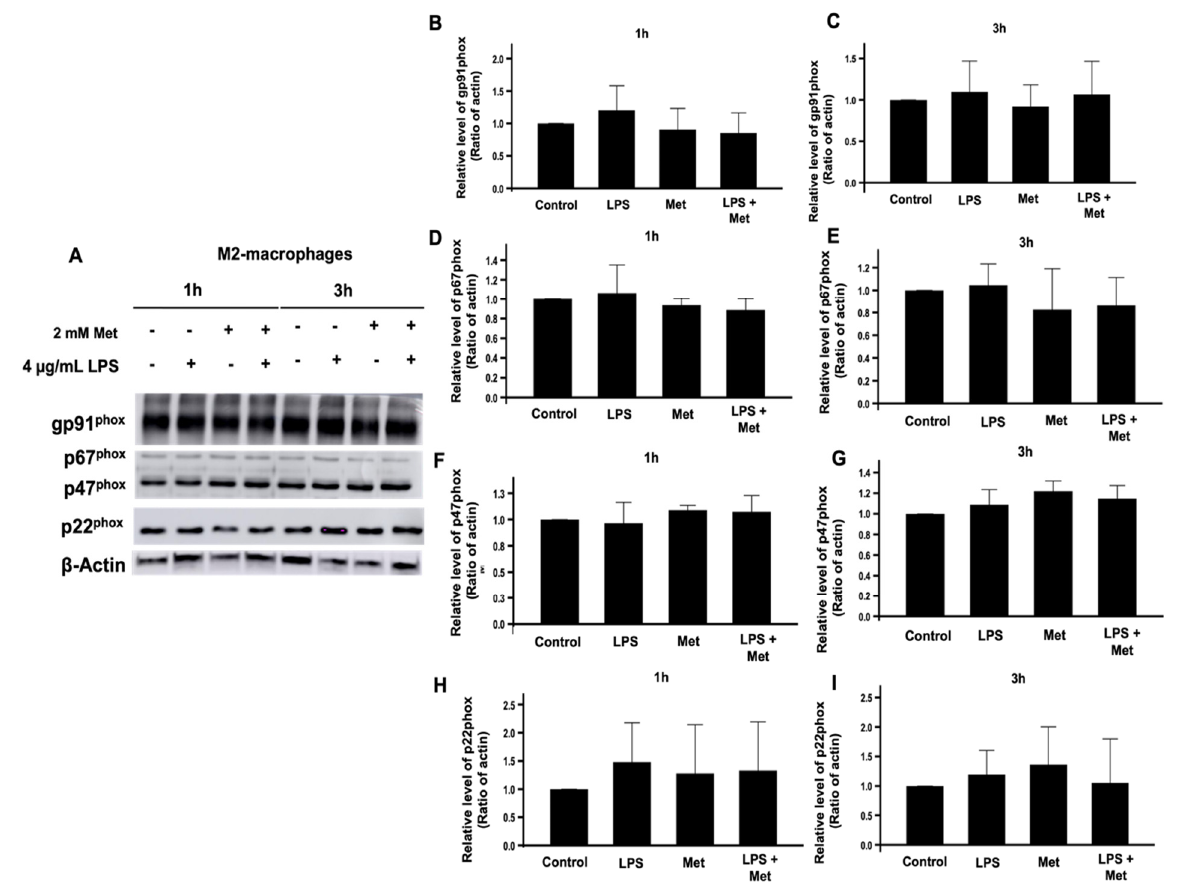
Figure 4. Effect of metformin on the expression of the NADPH oxidase components. M2 macrophages were incubated in the absence or the presence of 2 mM metformin then stimulated by LPS (4 µg/mL) for 1 and 3 h. The expression of gp91 phox , p22 phox , p47 phox , and p67 phox was evaluated compared to actin by SDS-PAGE and Western blot using specific antibodies ( A ). The gp91 phox ( B , C ), p67 phox ( D , E ), p47 phox ( F , G ), p22 phox ( H , I ) and actin bands from three experiments were quantified and expressed as mean ± SD.